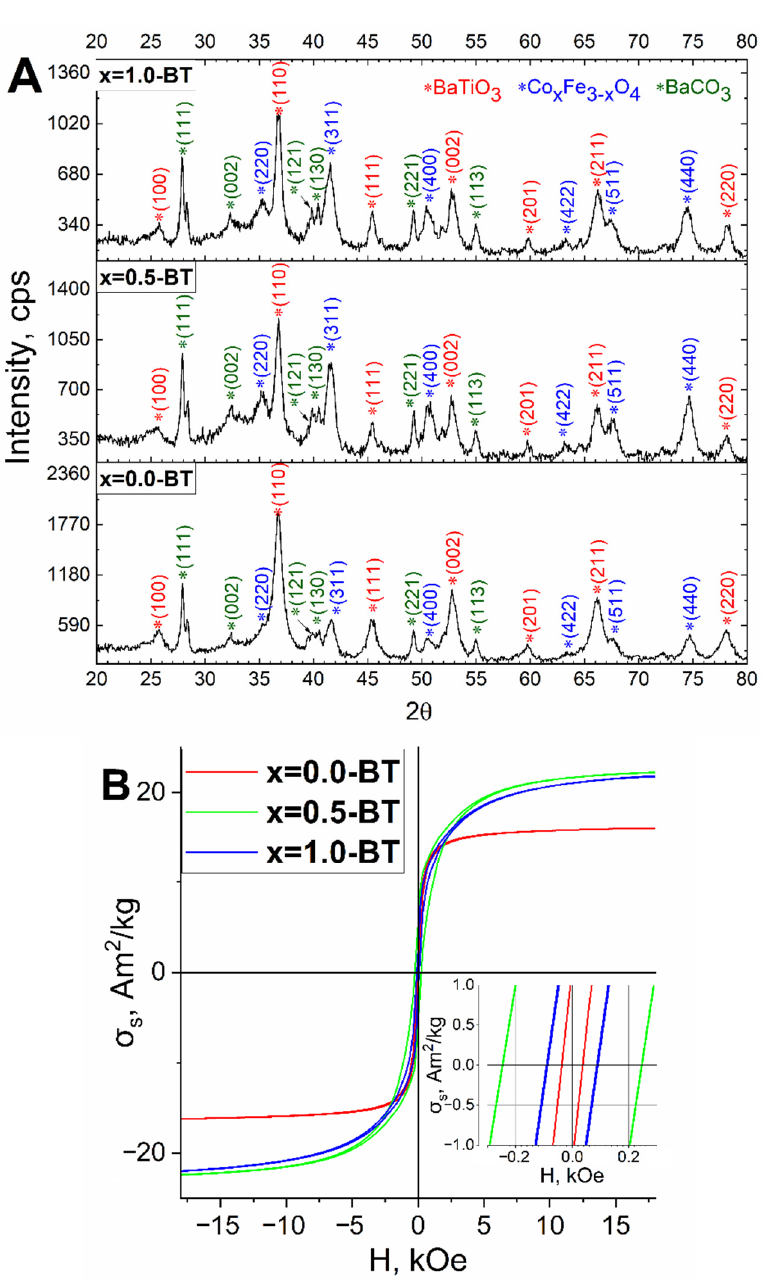
Figure 8. XRD ( A ) and magnetic measurement ( B ) data for the samples of x = 0.0-BT, x = 0.5-BT, and x = 1.0-BT after annealing.